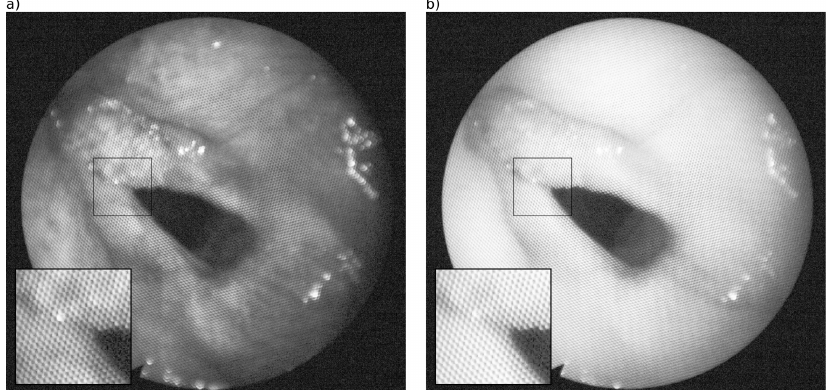
Figure 1. Hyperspectral (HS) images of the larynx of one example case (#caseA) at wavelength ( a ) 510 nm and ( b ) 610 nm showing the honeycomb-like pattern as a result of the hexagonally arranged fiber cables in the flexible